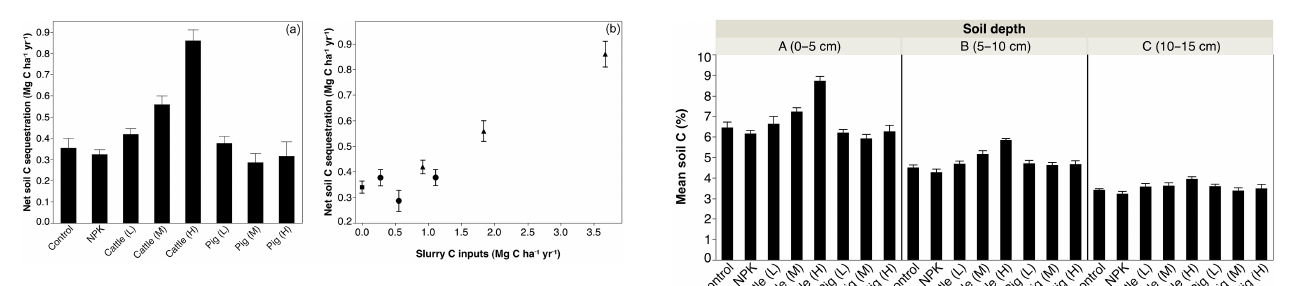
Figure 2. Relationship between net soil C sequestration rates (MgCha − 1 yr − 1 ; 0–15cm depth) and (a) nutrient application treat- ments, (b) C inputs from animal slurry (MgCha − 1 yr − 1 ) . Experi- mental treatments same as in Fig. 1. Symbols: square = no C inputs (control plots), circles = C inputs from pig slurry, triangles = C in- puts from cattle slurry. Standard errors indicate variation among six replicate values for each treatment.